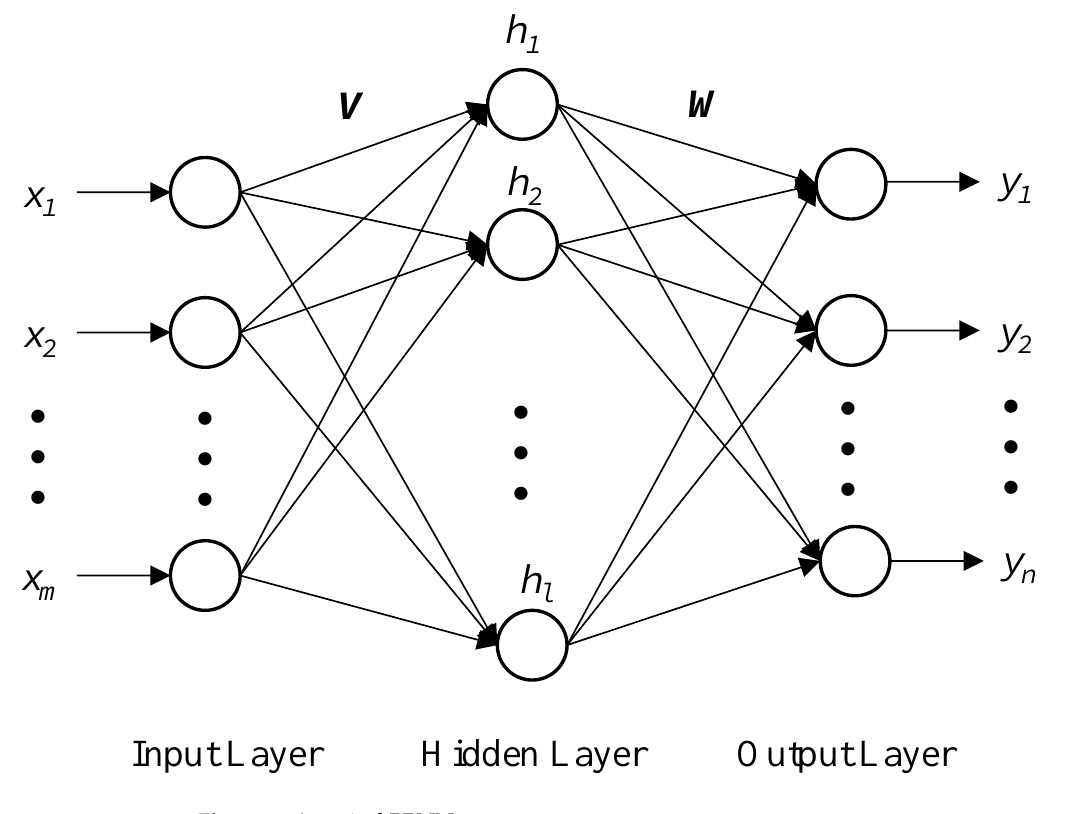
Figure 1. A typical BPNN.